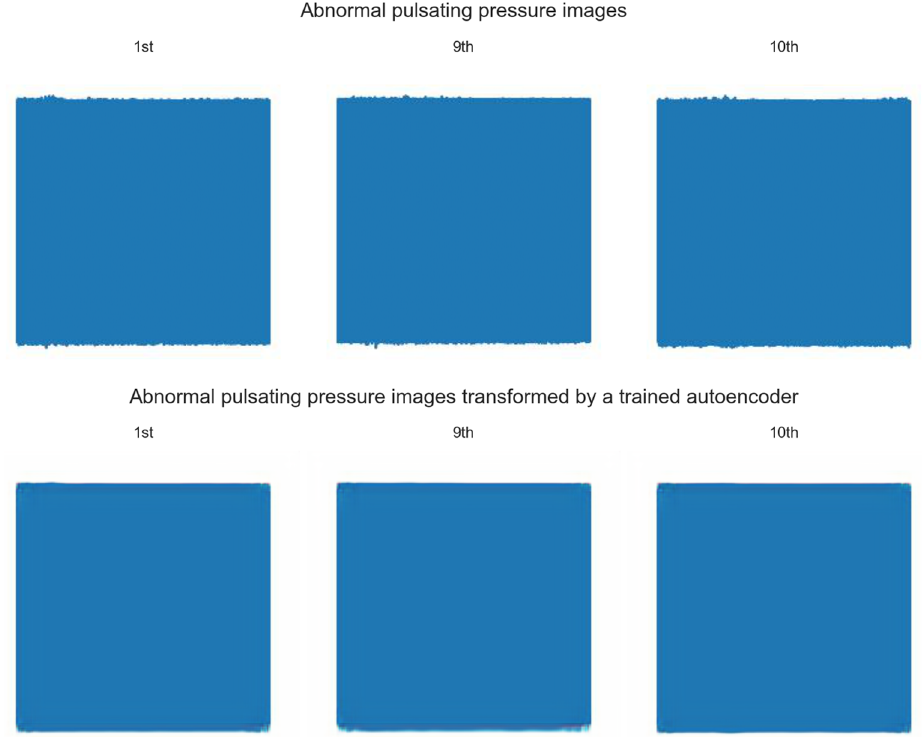
Figure 10. Abnormal pulsating pressure images and transformed images.